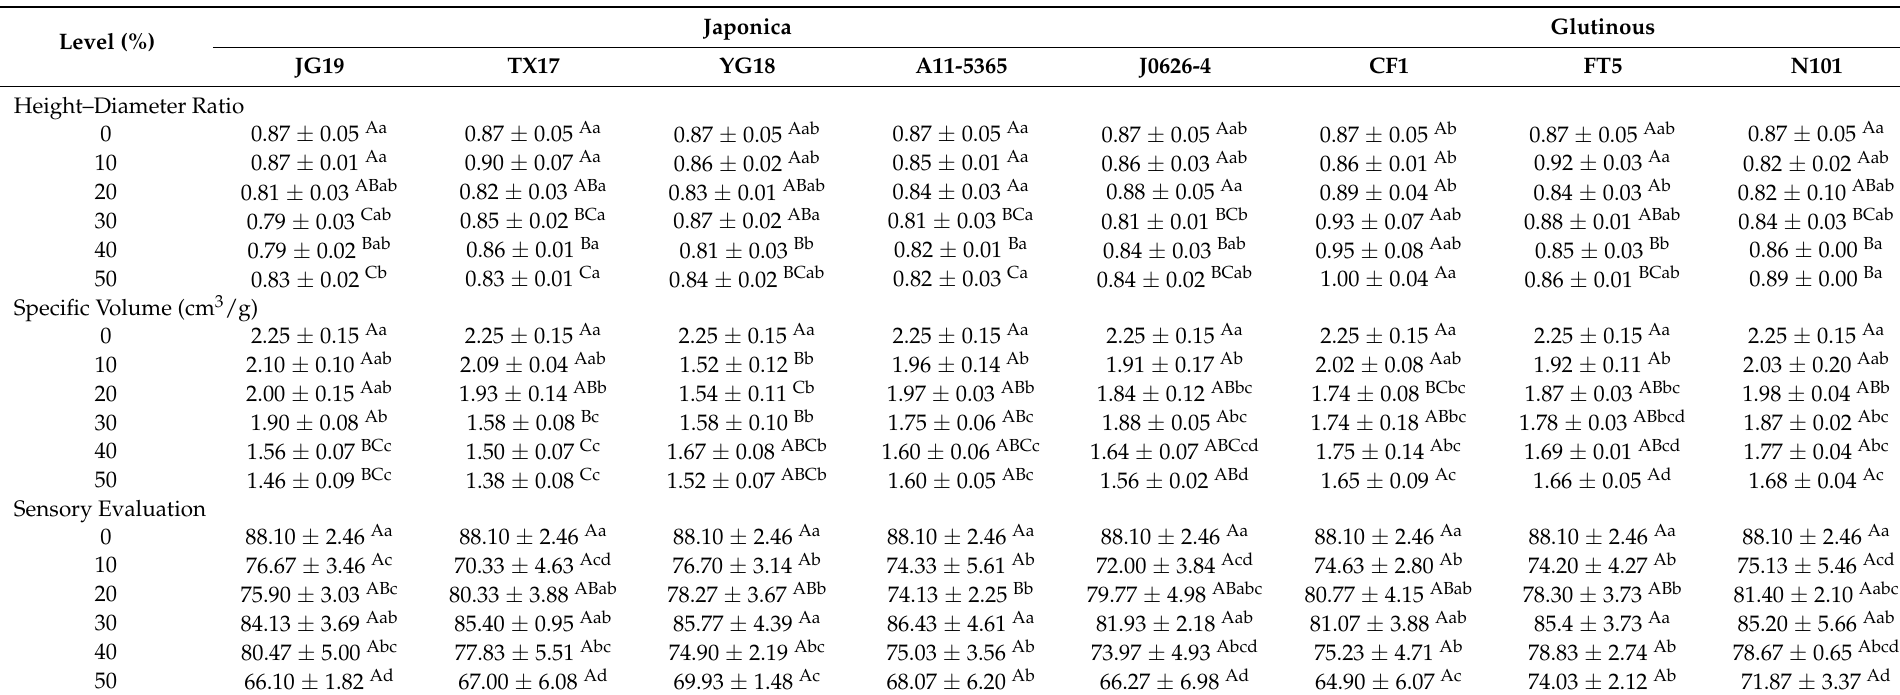
Table 2. Effect of different cultivars and addition of whole foxtail millet flour on height–diameter ratio, specific volume, and sensory evaluation of CSB ( n =